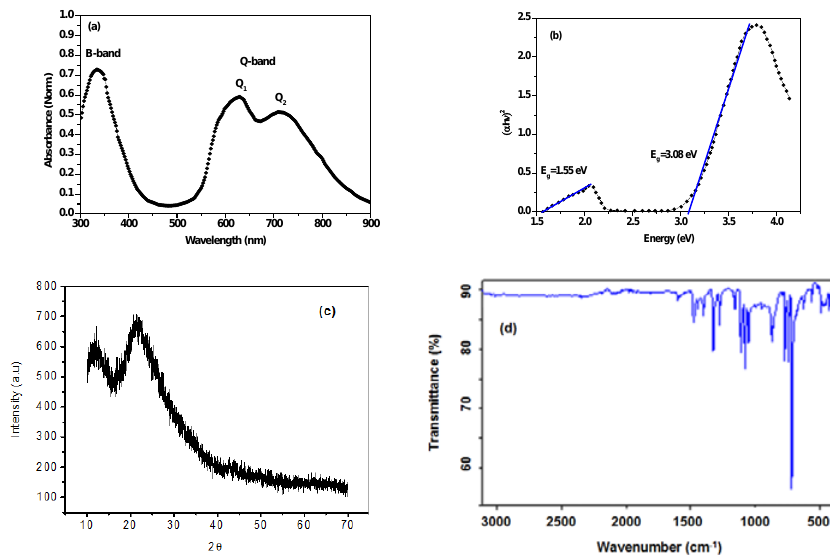
Figure 4. ( a ) UV-vis spectrum, ( b ) Tauc’s plot for energy bandgap calculation, ( c ) XRD pattern and ( d ) FTIR spectrum of ZnPc thin film evaporated at room temperature.